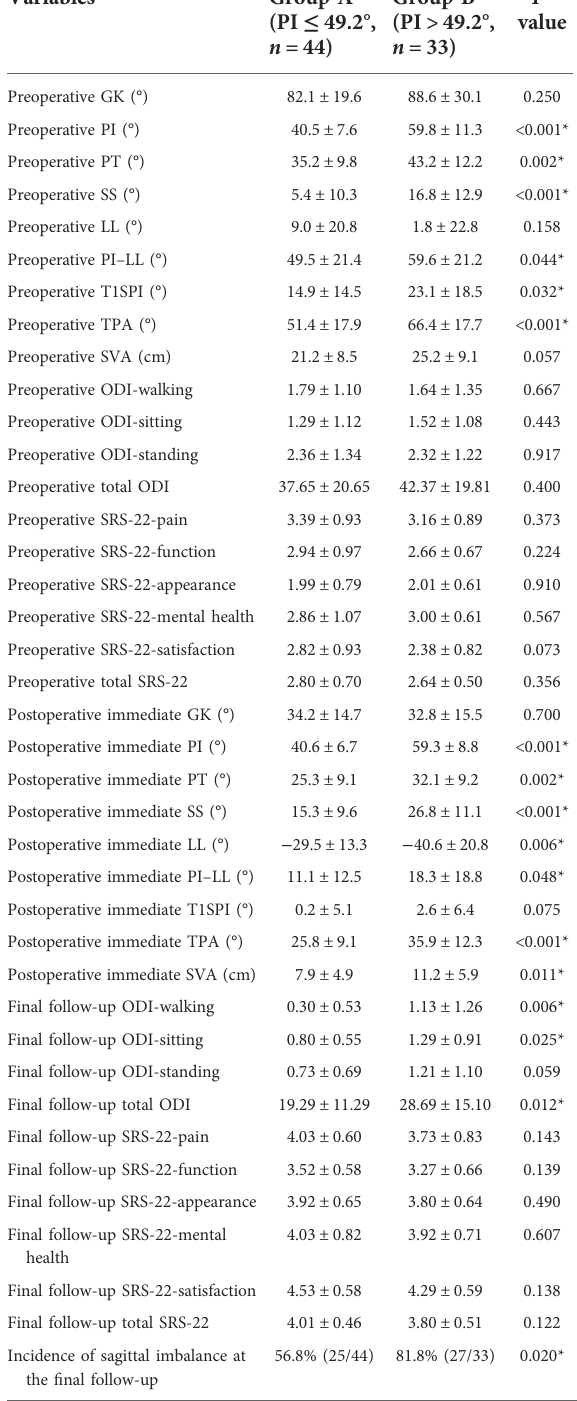
TABLE 5 Differences in radiographic parameters and clinical outcomes with different pelvic incidences.